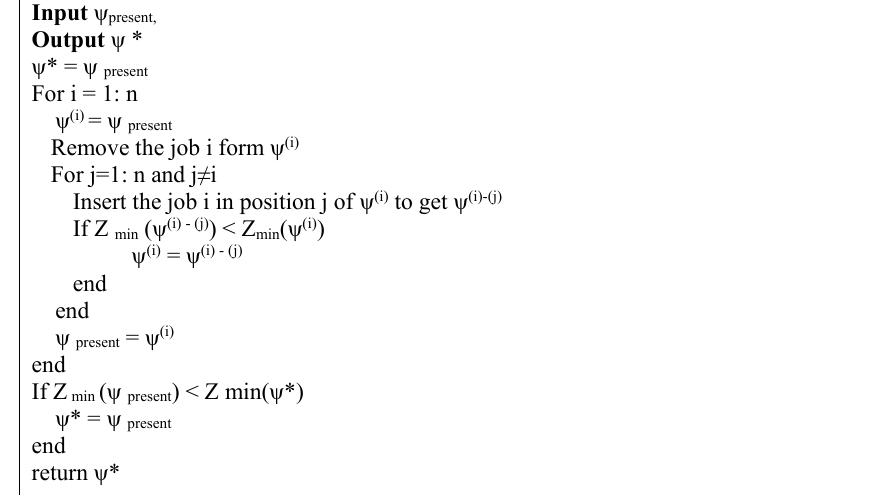
Fig. 4. Pseudocode for the local search for